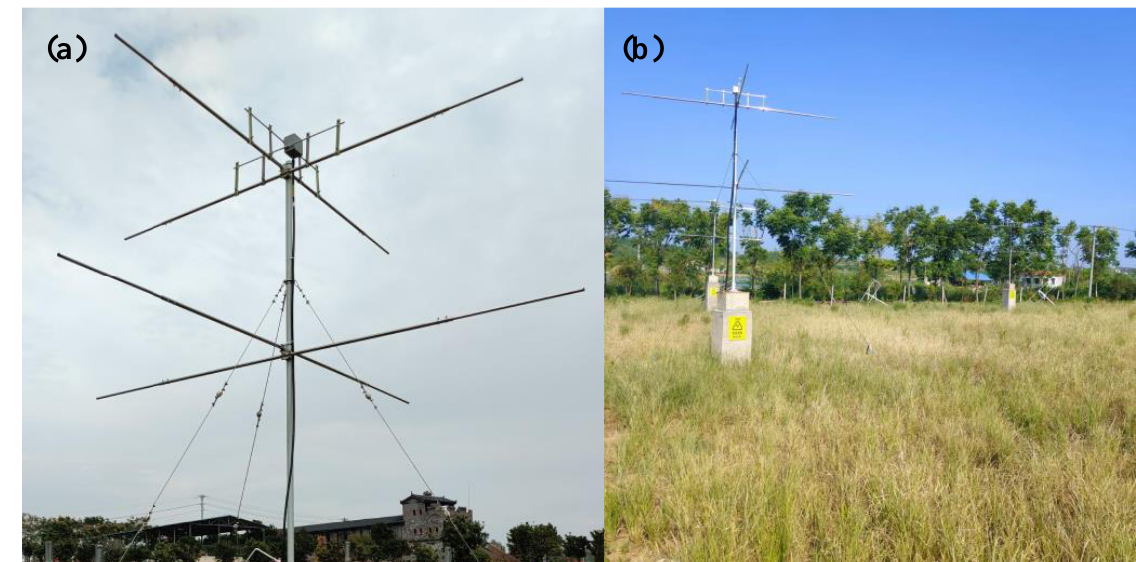
Remote Sens. 2023 , 15 , x FOR PEER REVIEW